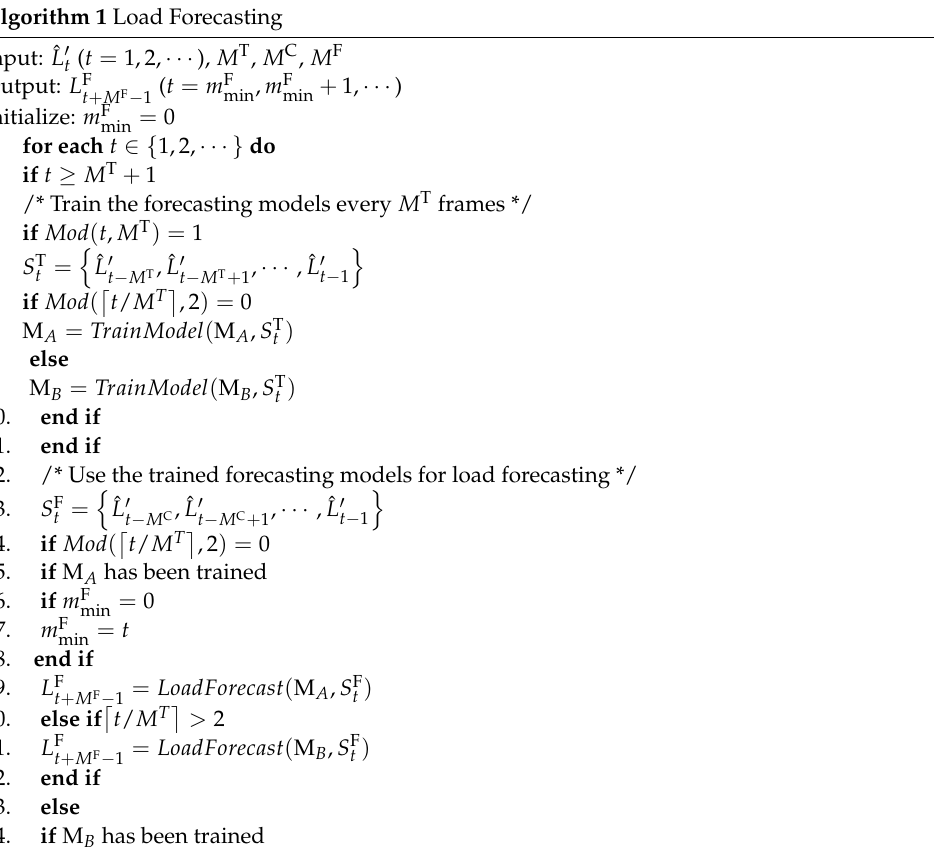
Algorithm 1 Load